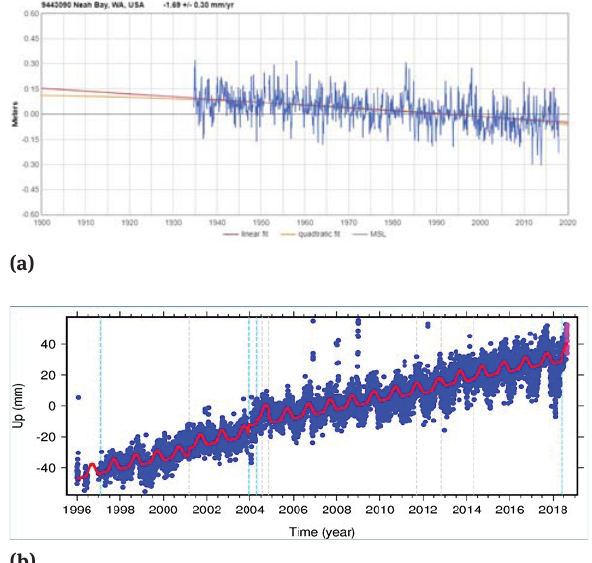
The closest GNSS Station from SONEL is NEAH of ab- solute vertical velocity of 3.25±0.29 mm/yr.